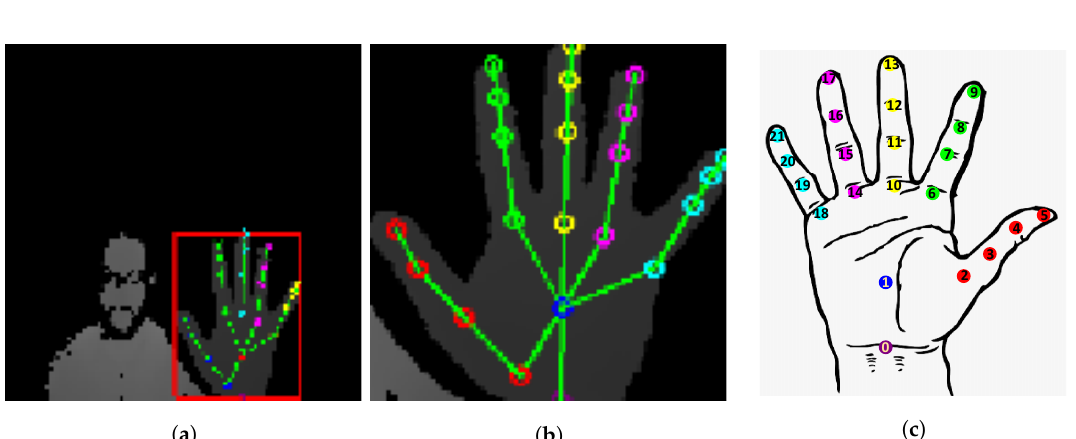
Figure 11. A sample hand posture in the DHG dataset: ( a ) hand depth data with drawing the hand bounding box and the 22 hand joints; ( b ) hand regions in zoom mode; ( c ) 22 hand joints with 0